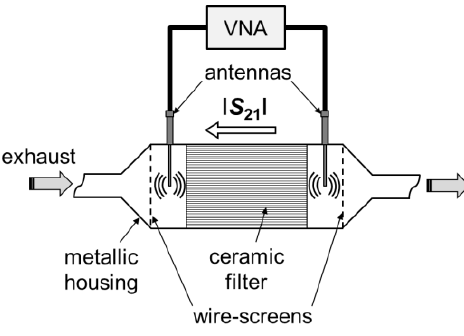
Figure 3. Setup of the microwave-based method for filter monitoring.